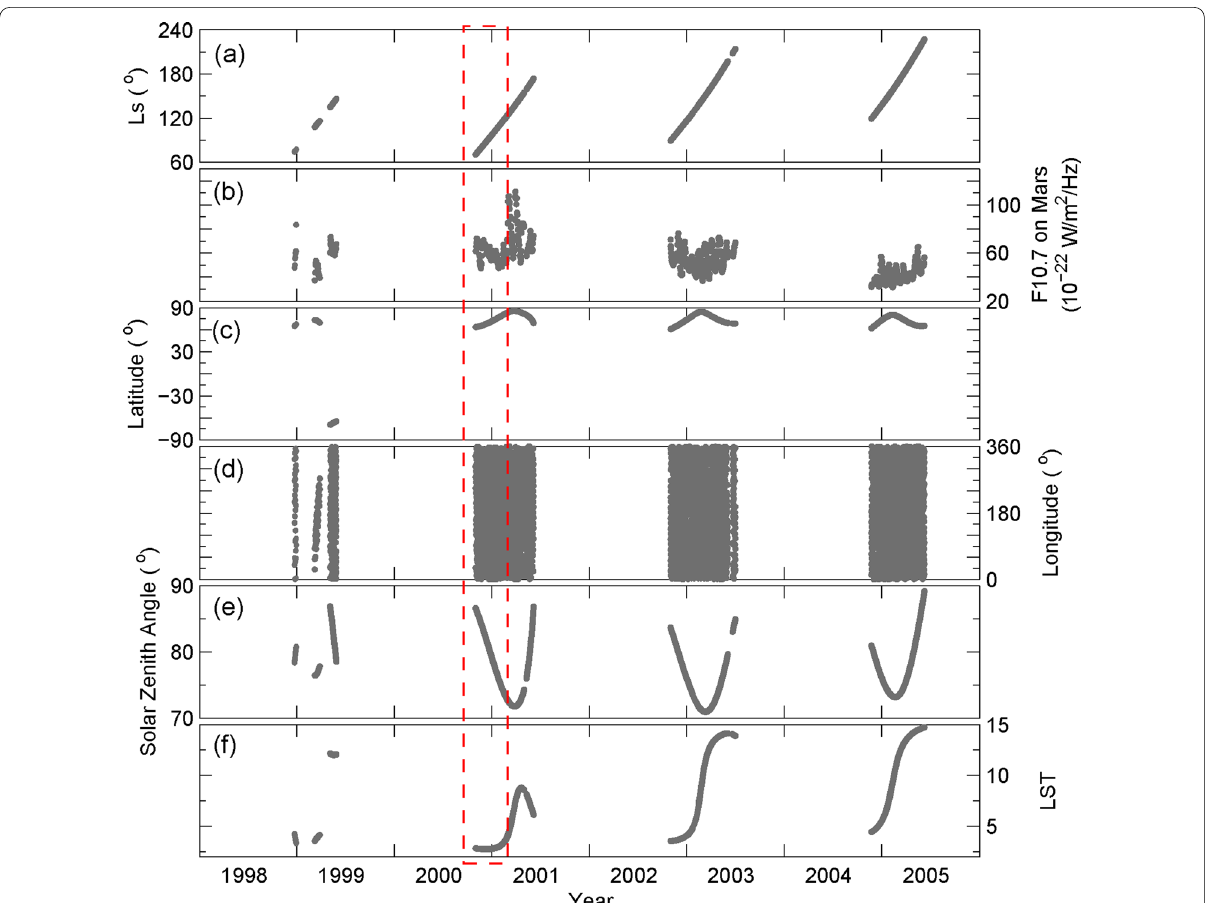
Fig. 2 Various parameters associated with the MGS radio occultation measurements. a Solar longitude of Mars Ls; b solar 10.7 cm radio flux on Mars; c latitude, d longitude, e the solar zenith angle, and f local solar time LST of the MGS radio occultation measurements. The red dashed box indicates the selected time segment used for this